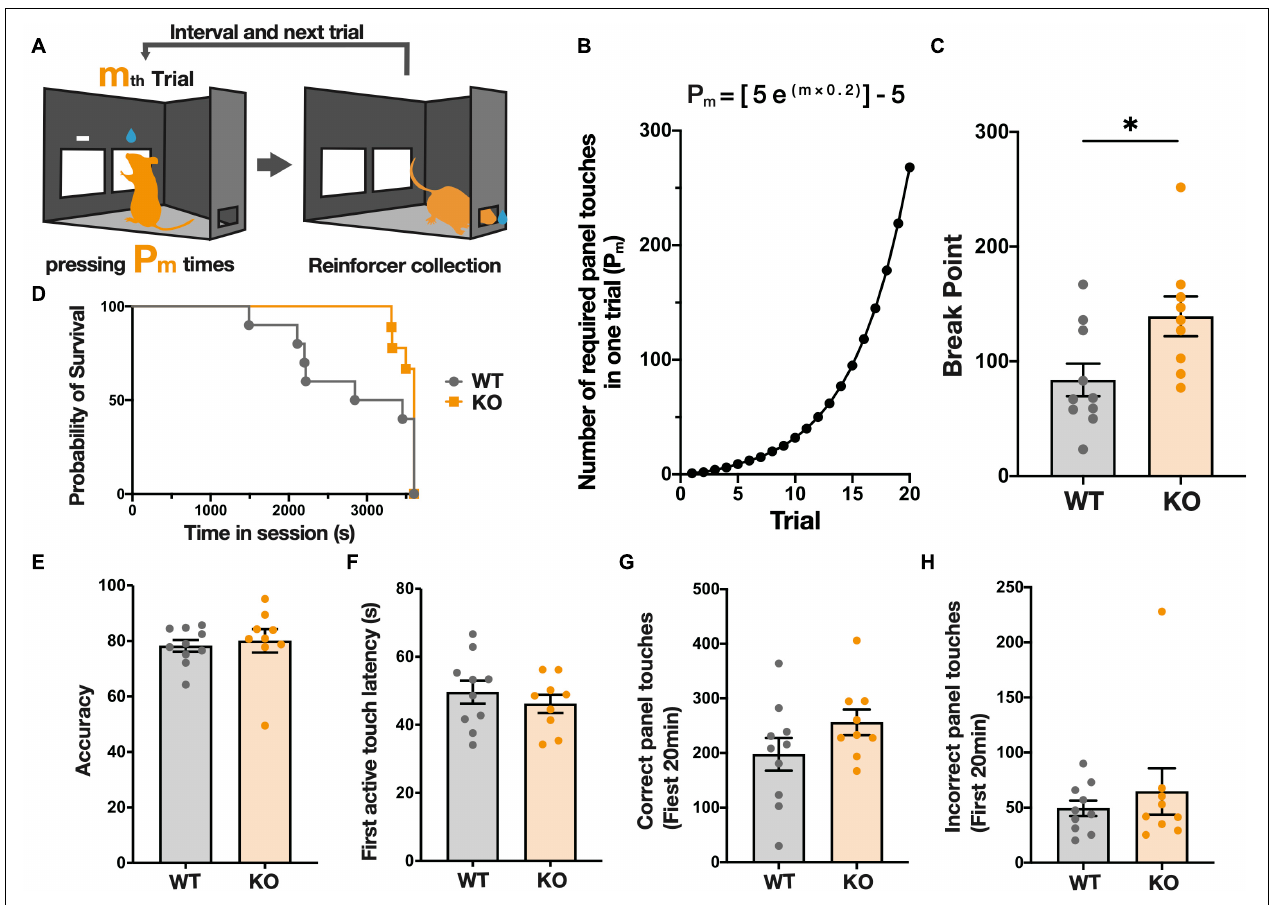
FIGURE 2 | KPNA3 KO mice show increased motivation to acquire a sucrose reward in a progressive ratio (PR) schedule test in comparison to WT mice. (A) Illustration of The PR schedule test. The right panel is the correct panel and the left is the incorrect panel (left image). m is the order number of a trial and P m is the response ratio. Following a correct response mice can collect a reward from the rear reward magazine (right image). (B) The ratio schedule of the PR schedule test. (C) Break Point: number of panel touches required to obtain the reward at the time when the mouse finishes the task. (D) Survival curve of the duration until the end of the session (no touch for 5 min, or 60 min). (E) Correct panel ratio in the entire session (correct touches/total panel touches). (F) Average time between the start of the trial and the first panel touch. (G,H) The number of correct/Incorrect touches in the first 20 min (the shortest session). Data represent the mean ± SEM, ∗ p < 0.05, Student’s t -test for column data and A log-rank (Mantel-Cox) test for survival data (WT = 10, KO =